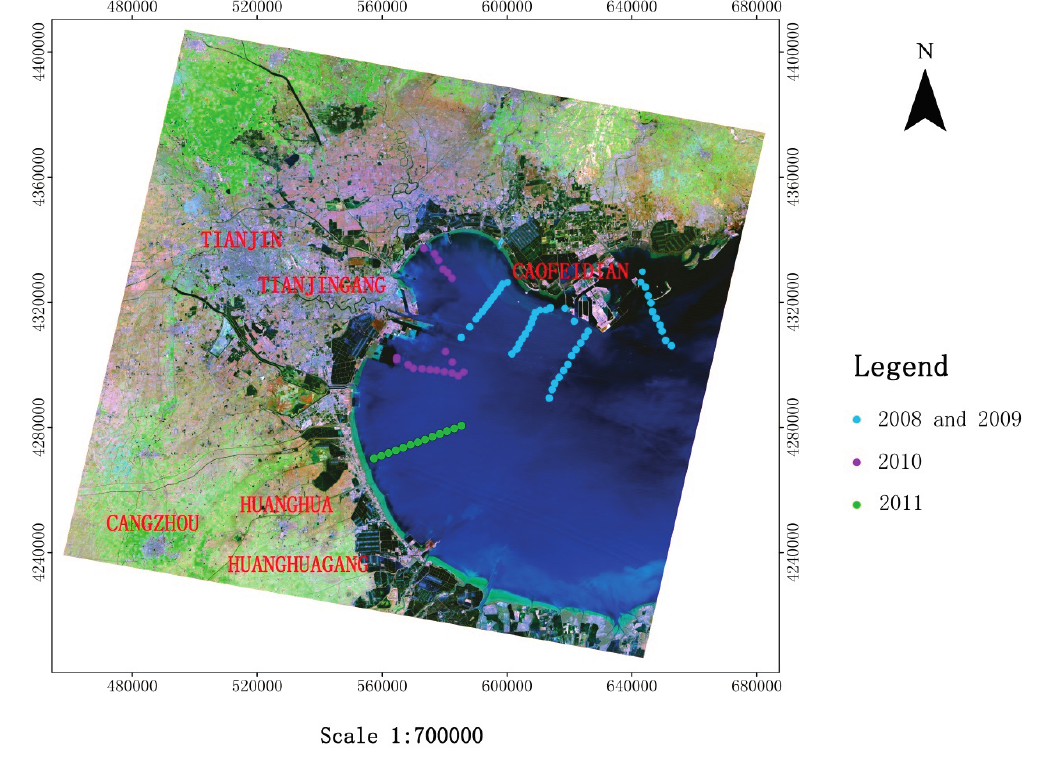
Figure 1. Sample locations of 11 transects in the Gulf of Bohai from 2008 to 2011. Among the 11 transects, 4 transects in 2008 and 2009 were at the same locations. At each station, radiometric measurements were performed using a double channel spectrometer (ASD). Water samples were also gathered